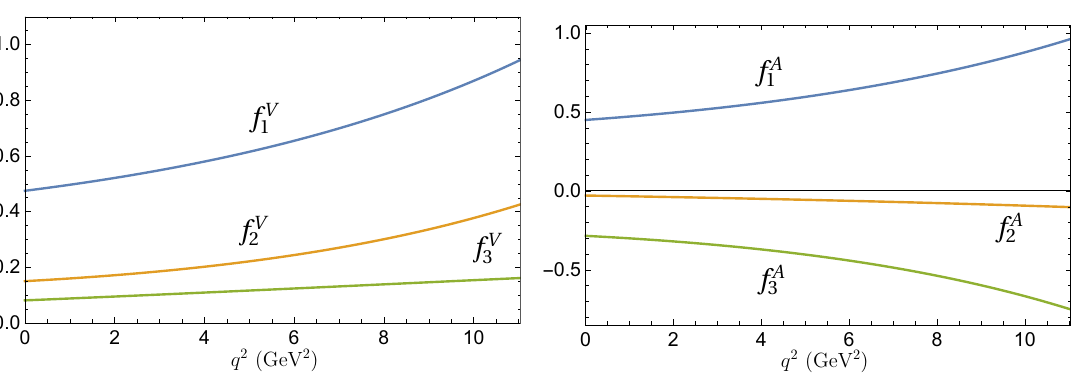
Figure 2. Form factors of the weak Ξ b ( right ) weak